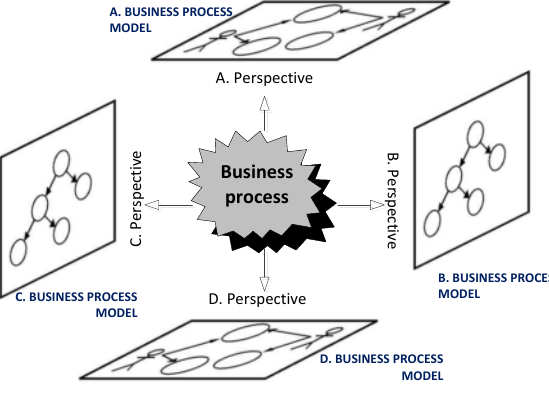
Figure 3. Business process modeling from different perspectives